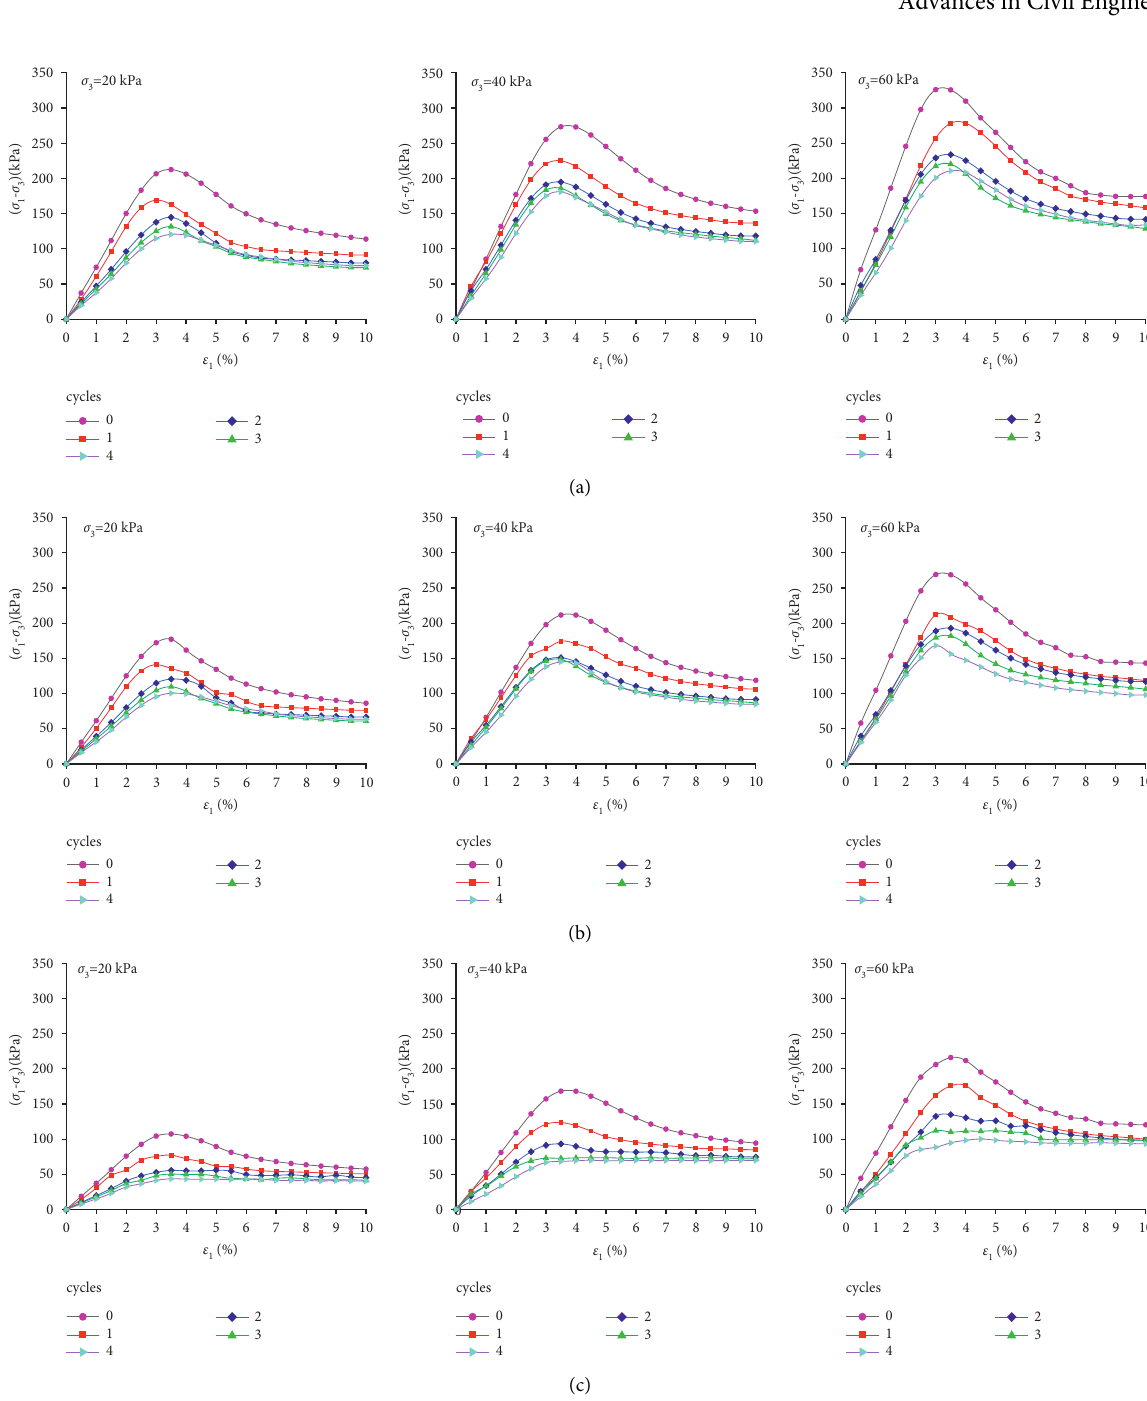
Figure 7: Stress-strain curves of compacted residual soil: (a) K � 98%; (b) K � 95%; (c) K �